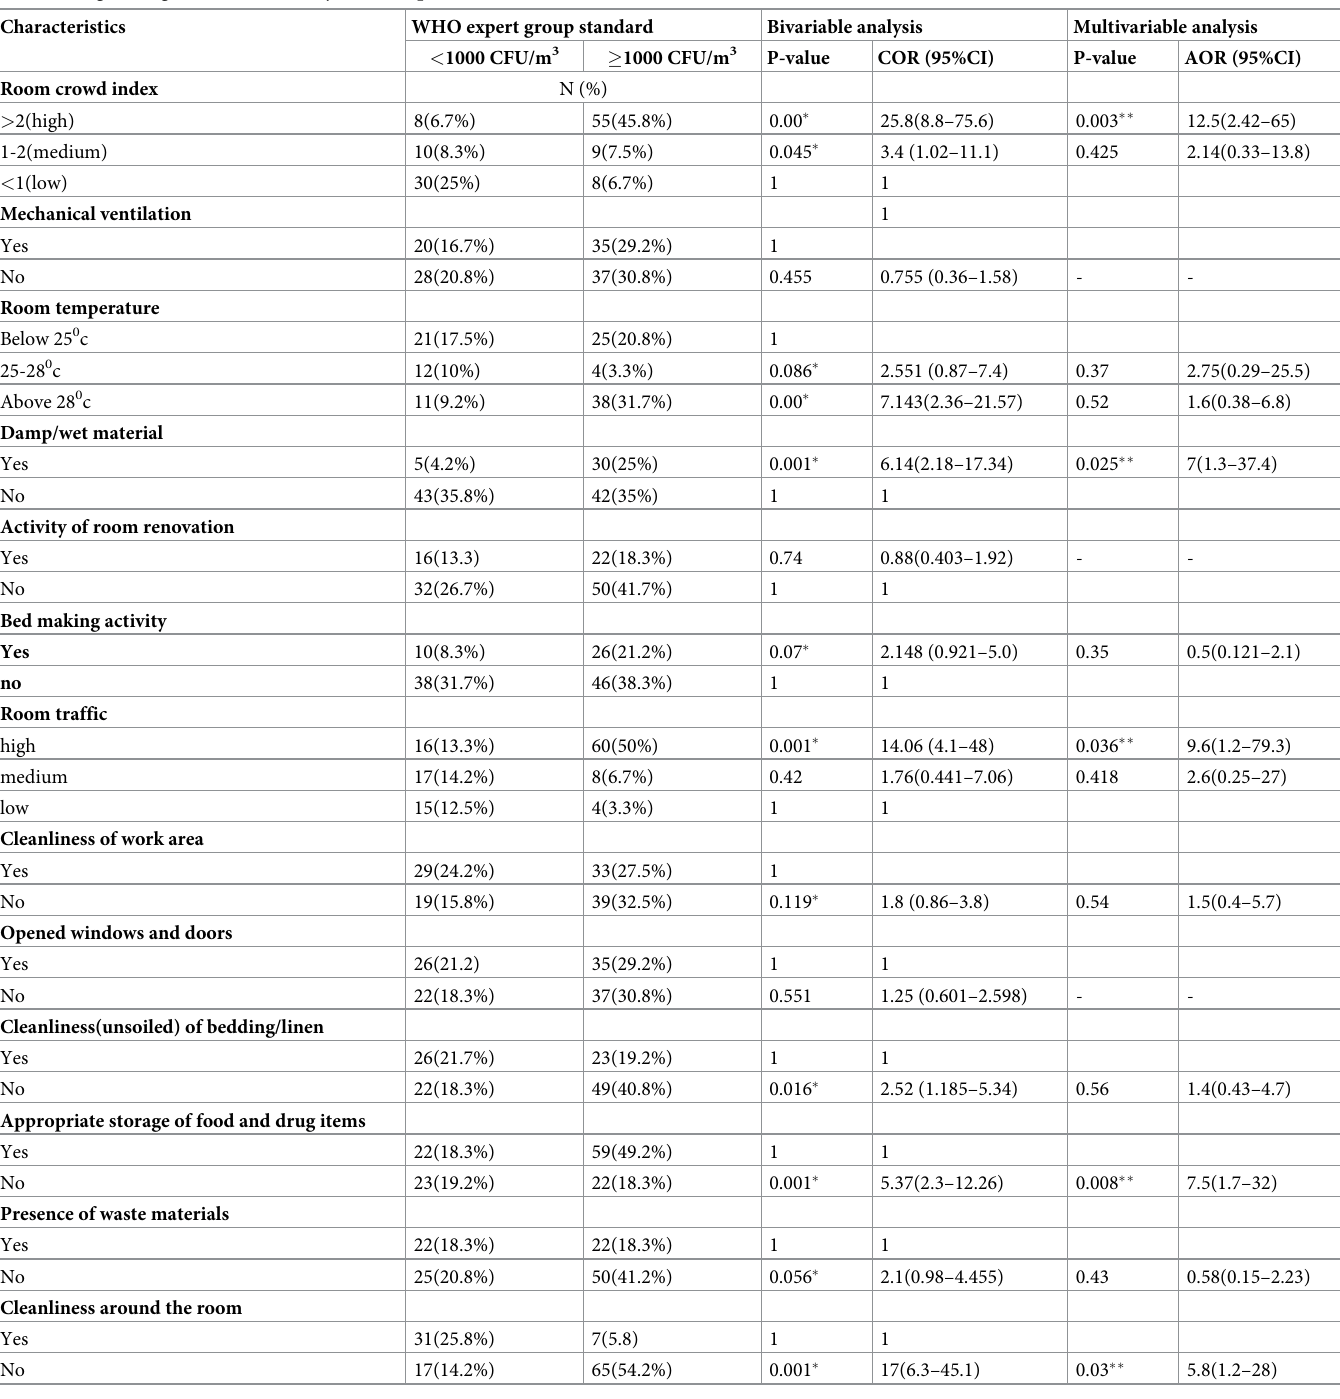
Table 7. Logistic regression model analysis of independent variables associated to the indoor air microbial